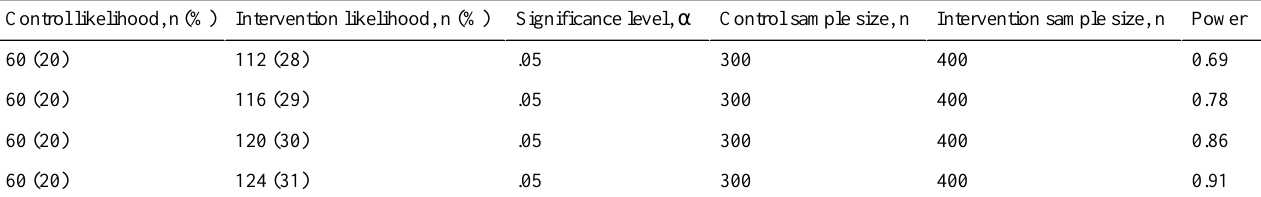
Table 7. Power calculations for intentions to switch methods, targeted counseling